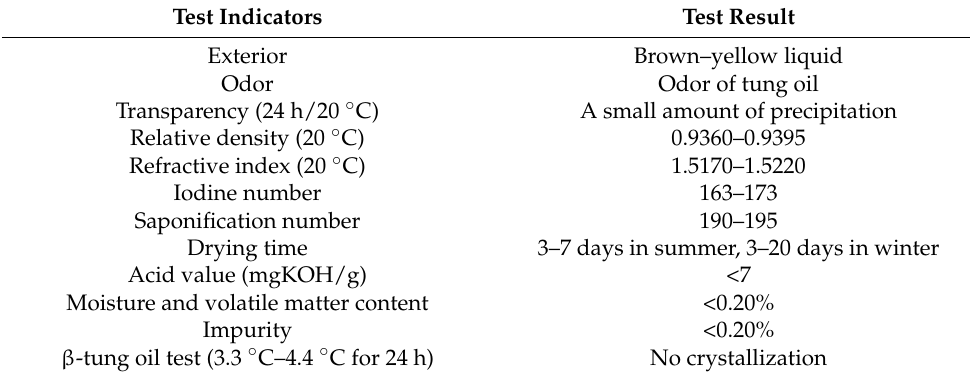
Table 2. The physical and chemical properties of compatibilizer.